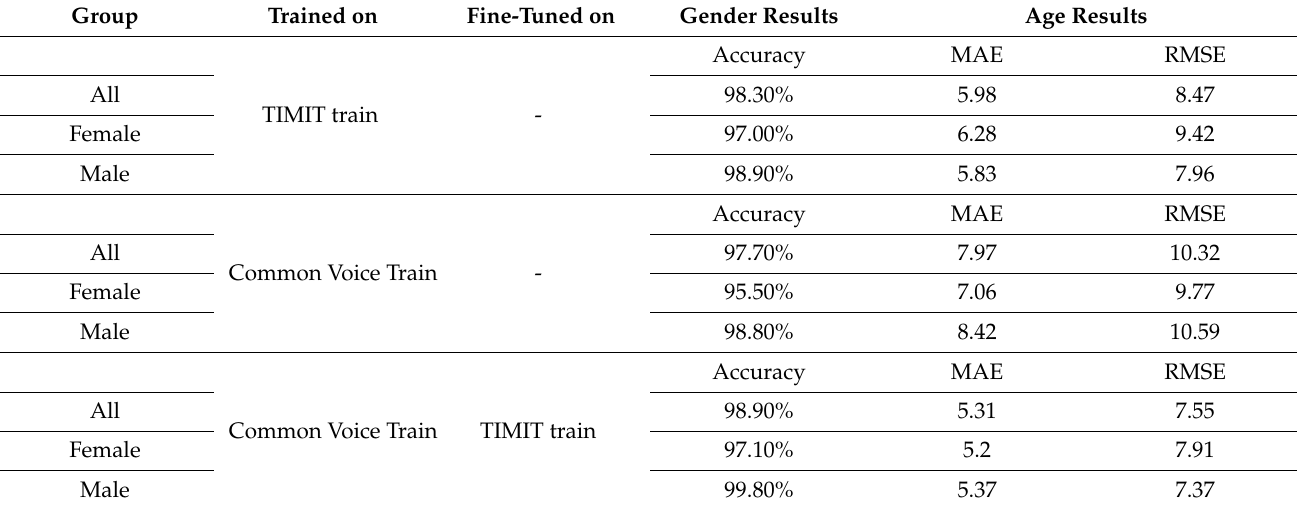
Table 9. Results on the TIMIT est dataset with a Quartznet-based x-vector embedder and volume normalization.